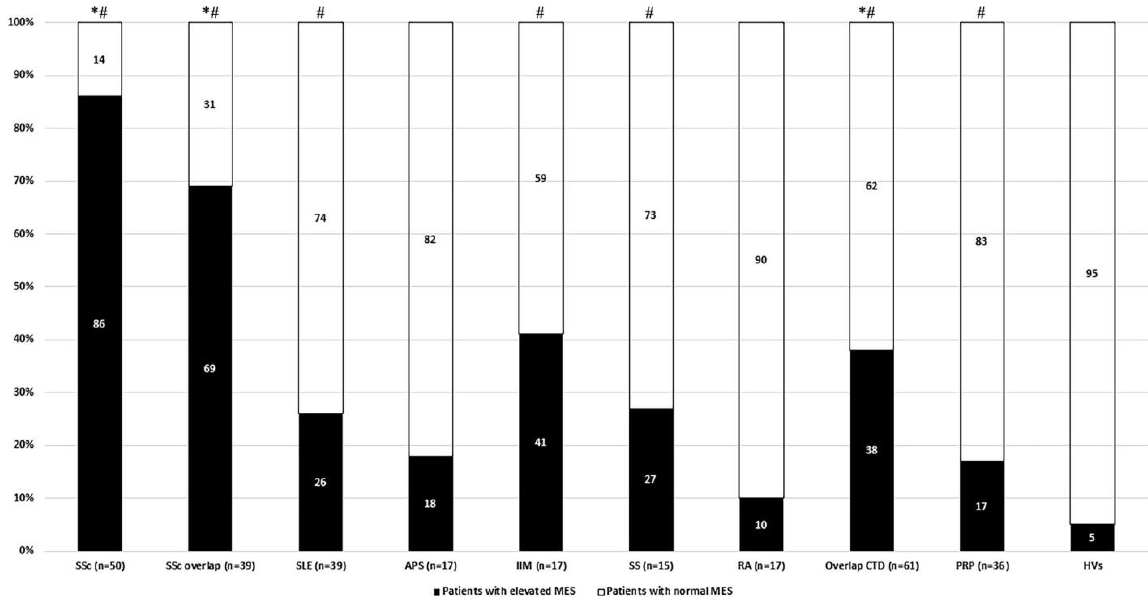
Figure 4. Prevalence of elevated MES in the investigated groups of patients. * p < 0.05 or lower significance compared with PRP. # p < 0.05 or lower significance compared with HV